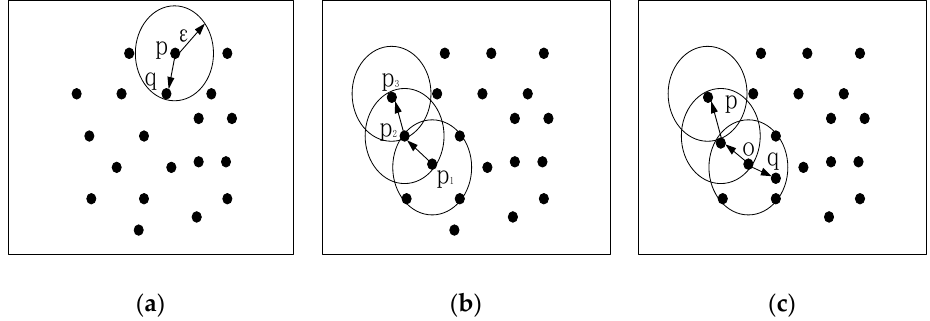
Figure 1. ( a ) description of direct density reachable; ( b ) description of density reachable; ( c ) description of density connected.